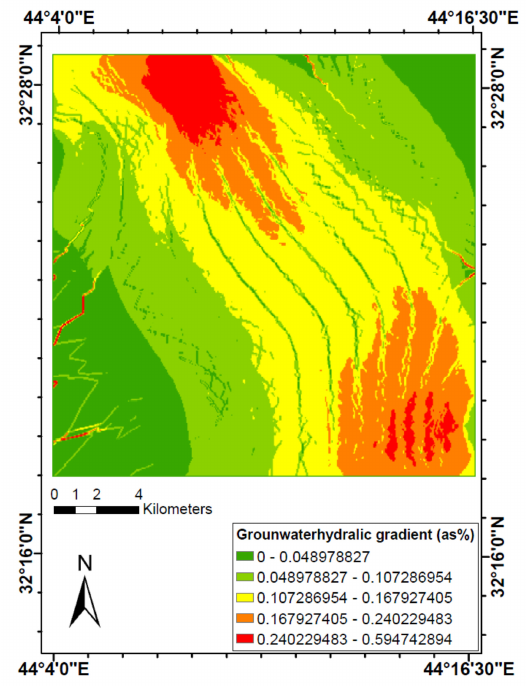
Figure 18. Groundwater hydraulic gradient in the Dibdibba study area.